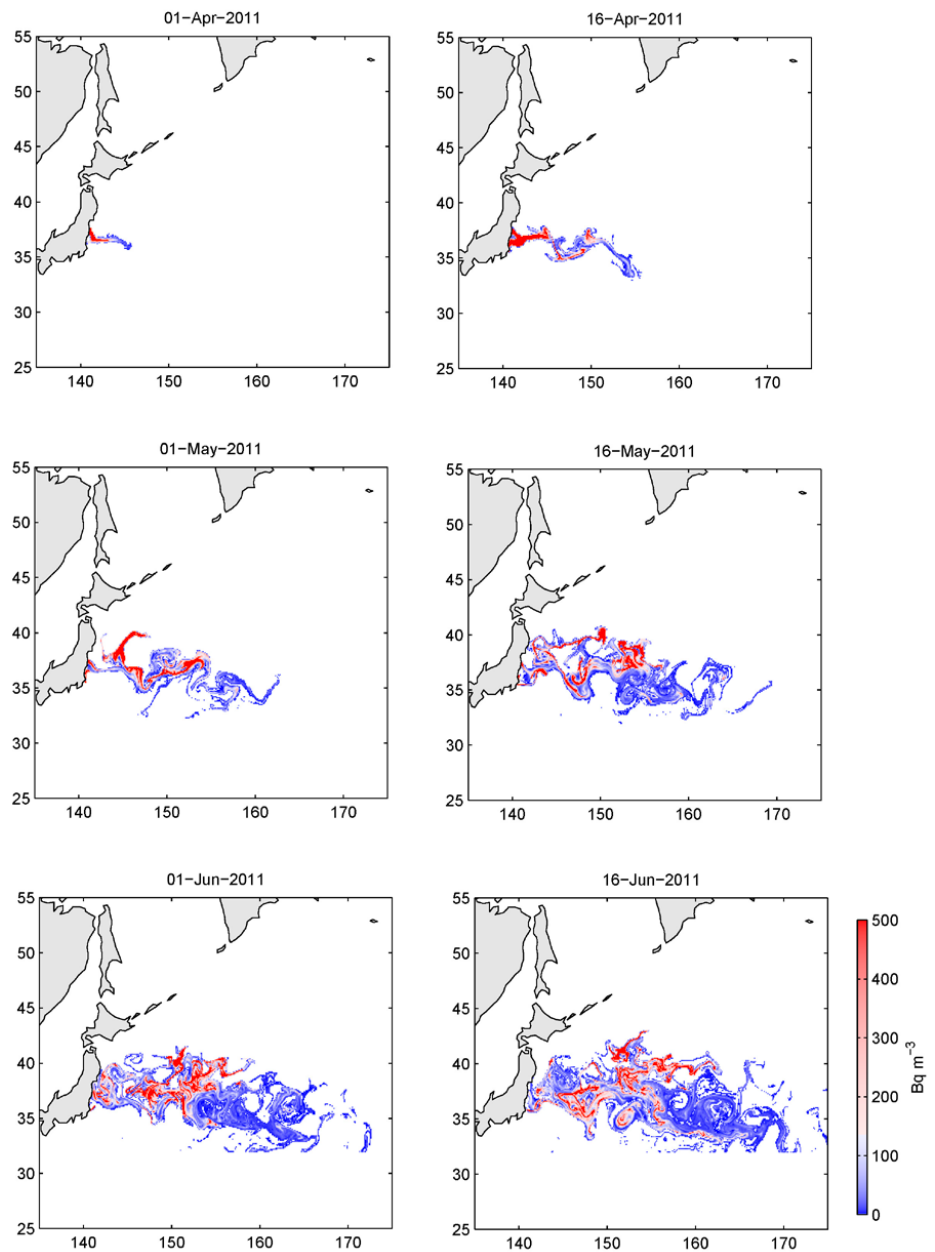
Fig. 5. Modeled 137 Cs concentration within the mixed layer on select dates derived from the observation-based model for the oceanic source. Colors are saturated at 500Bqm − 3 . The source domain is taken to be 20 × 20km 2 square centered at the FNPP. Source strength is 16.2 PBq.